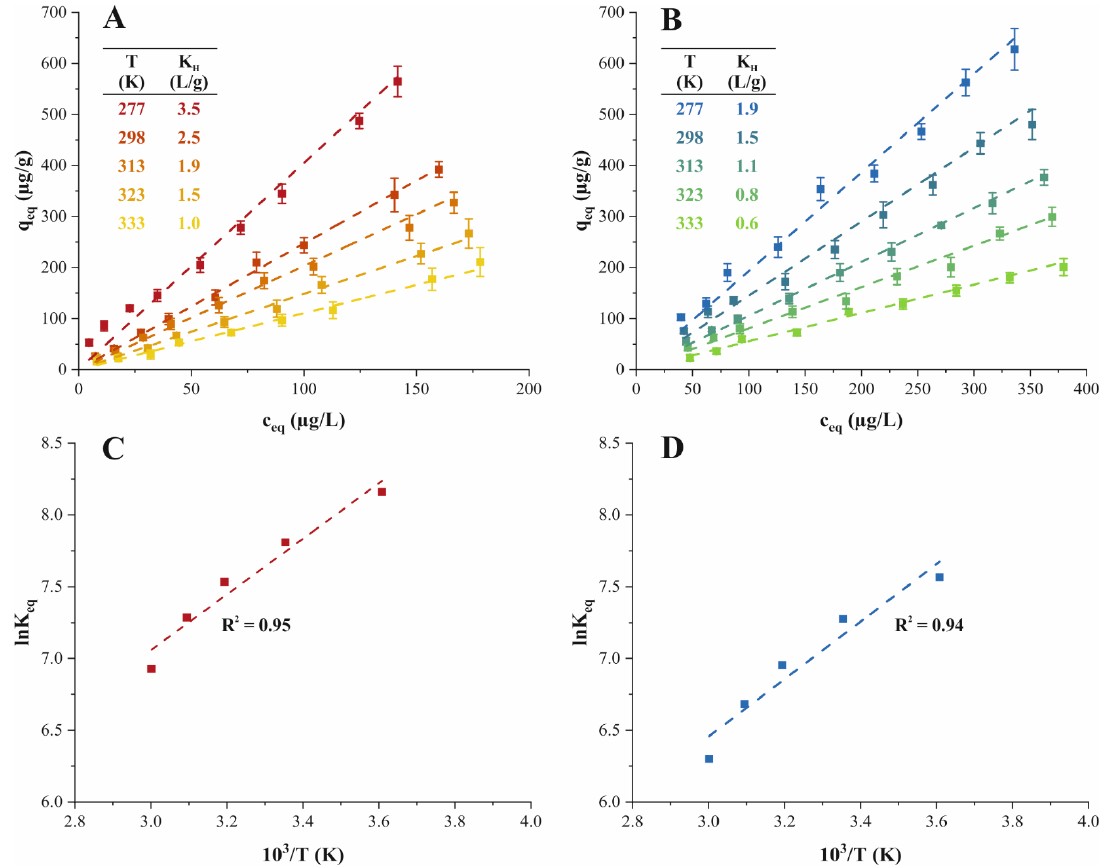
Figure 4. Experimental data ( ■ ) and Henry isotherm model ( - - - ) of the effect of temperature on the adsorption perfor- Figure 4. Experimental data ( (cid:4) ) and Henry isotherm model ( ) of the effect of temperature on the adsorption per- Figure 1. Representative SEM micrographs. ( A ) inside of PPH; ( B ) outside of PPH, at a series of magnifications. ( C , D ) FTIR Figure 2. Experimental data ( ■ ) and Henry isotherm model ( - - - ) of the adsorption isotherms for ( A ) TMP ( — ) and ( B ) Figure 1. Representative SEM micrographs. ( A ) inside of PPH; ( B ) outside of PPH, at a series of magnifications. ( C , D ) FTIR Figure 1. Representative SEM micrographs. ( A ) inside of PPH; ( B ) outside of PPH, at a series of magnifications. ( C , D ) FTIR mance of ( A ) TMP ( — ) and ( B ) ATN ( — ) on PPH. Van’t Hoff plot and regression line ( - - - ) of ( C ) TMP ( — ) and ( D ) Figure 2. Experimental data ( ■ ) and Henry isotherm model ( - - - ) of the adsorption isotherms for ( A ) TMP ( — ) and ( B ) ATN adsorption ( — ) on PPH in the ppb concentration range. Experimental data ( ■ ) and Langmuir isotherm model ( - - - spectra of TMP ( — ), ATN ( — ), PPH ( — ) and after adsorption of TMP ( — ) or ATN ( — ) on PPH. spectra of TMP ( — ), ATN ( — ), PPH ( — ) and after adsorption of TMP ( — ) or ATN ( — ) on PPH. spectra of TMP ( — ), ATN ( — ), PPH ( — ) and after adsorption of TMP ( — ) or ATN ( — ) on PPH. Figure 1. Representative SEM micrographs. ( A ) inside of PPH; ( B ) outside of PPH, at a series of magnifications. ( C , D ) FTIR ATN ( — ) adsorption on PPH. Different letters denote significant differences between isotherm points ( p < 0.05, n = 3). ) of the adsorption isotherms for ( C ) TMP ( — ) and ( D ) ATN adsorption ( — ) on PPH in the ppm concentration range. ATN adsorption ( — ) on PPH in the ppb concentration range. Experimental data ( ■ ) and Langmuir isotherm model ( - - - spectra of TMP ( — ), ATN ( — ), PPH ( — ) and after adsorption of TMP ( — ) or ATN ( — ) on PPH.